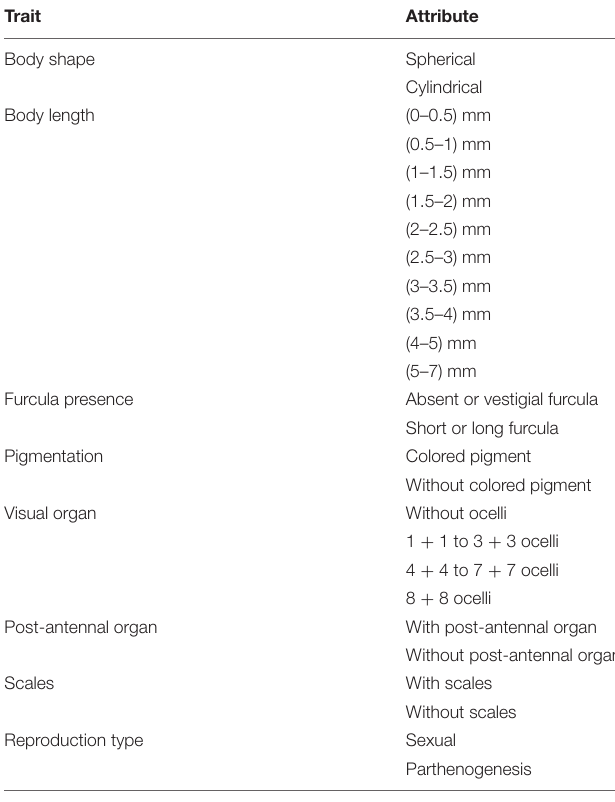
TABLE 3 | Description and attributes of morphological, behavioral, and physiological traits considered for the trait-based approach to the collembolan community.